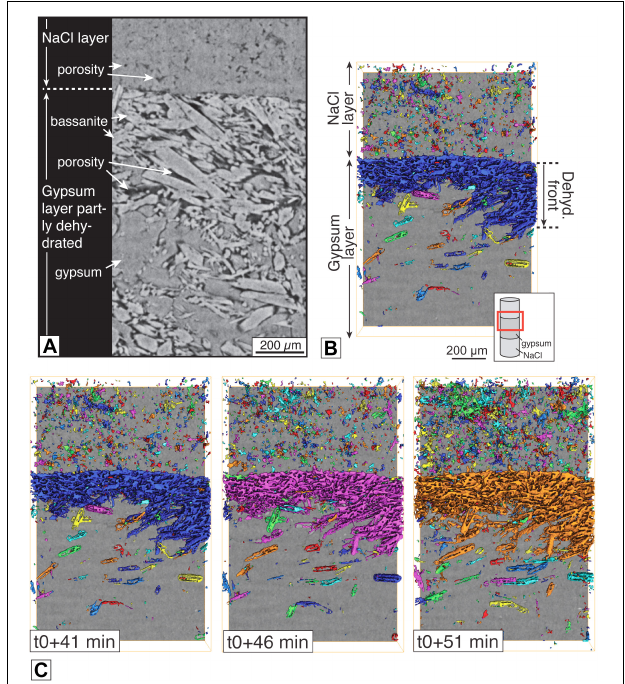
FIGURE 7 | Porosity evolution. (A) Microstructure overview. Sub-area of reconstructed XTM scan, vertical cross section. (B) Explanatory image for how to read data in (C) . 3D subvolume of segmented porosity. To each pore, an individual color is assigned (although colors repeat). The subvolume contains part of an NaCl layer to the top, a gypsum layer to the bottom and a dehydrated layer traveling from the NaCl – gypsum interface downwards into the gypsum layer. The large connected pore volume (large blue pore) shows how porosity in the dehydrated layer is well connected. (C) Time-series of pore network evolution with a time step of 5 min between successive time